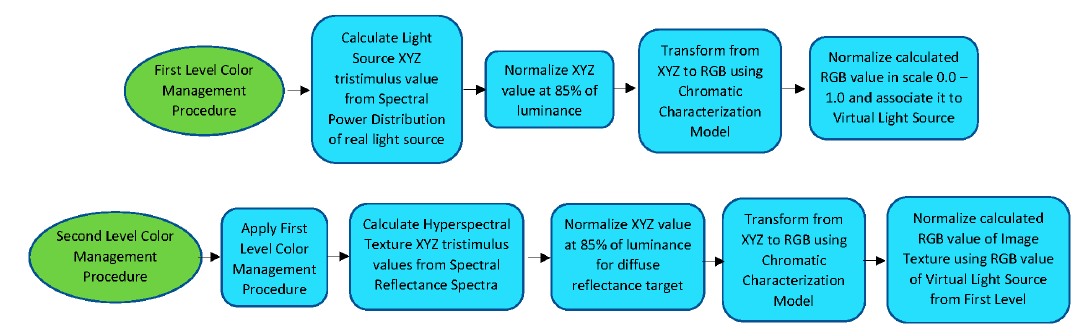
Figure 6. Flux diagram for both levels of the Color Management Procedure.